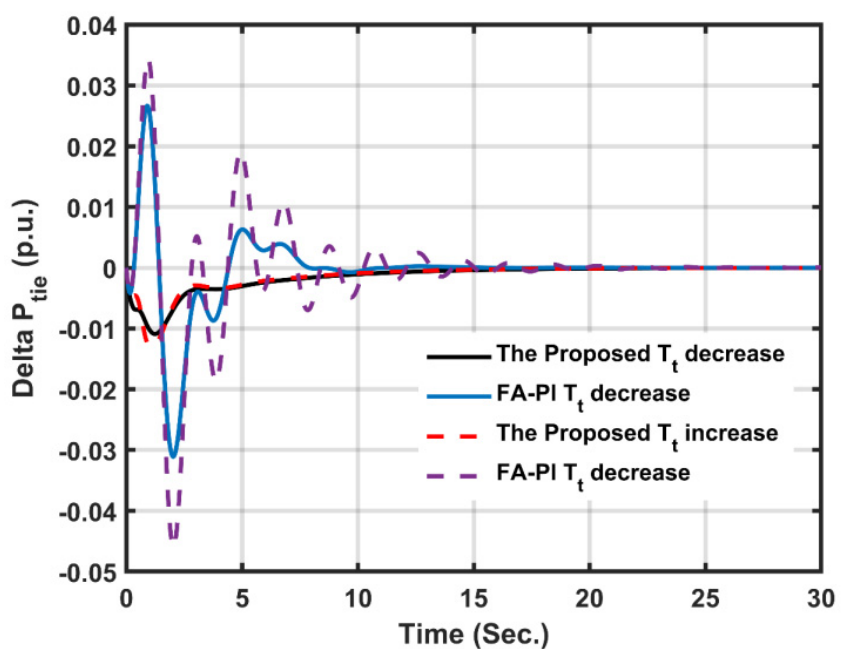
Figure 27. Tie line power deviation under T t changes.